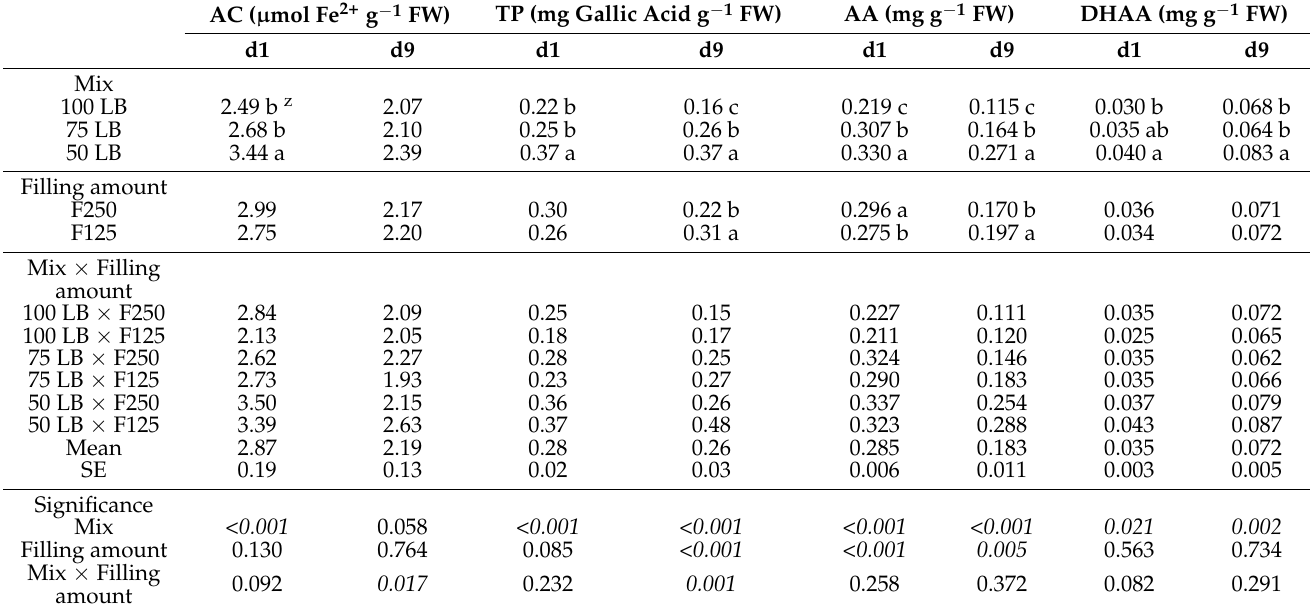
Table 3. Antioxidant properties of the fresh-cut baby leaf lettuce and rocket during